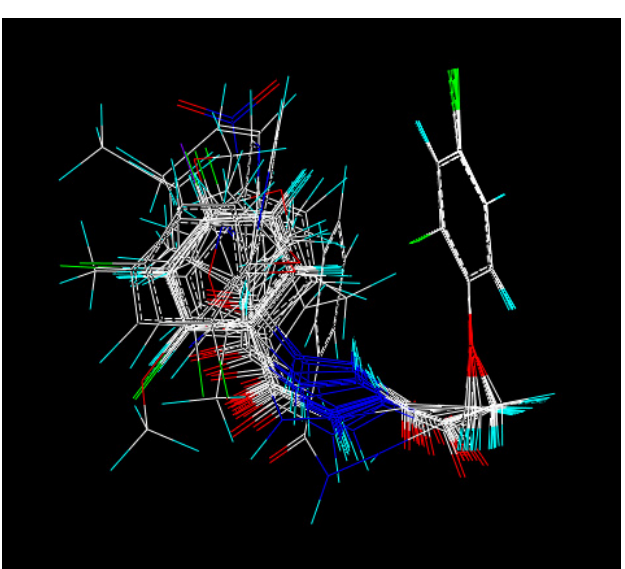
Figure 5. Superposition modes of